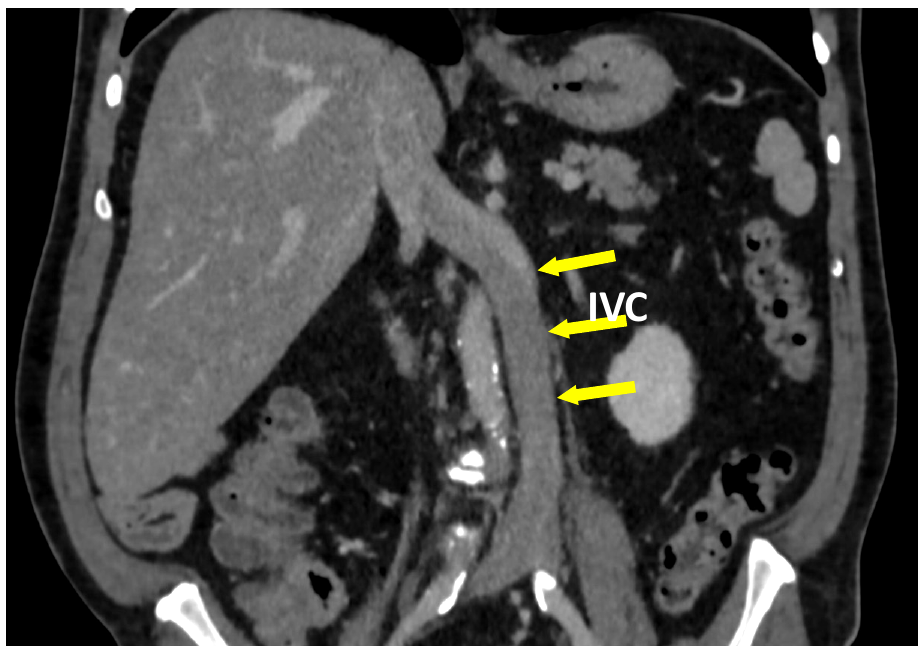
Figure 8. The coronal plane of a CT-V scan in a patient with left-sided inferior vena cava (IVC).